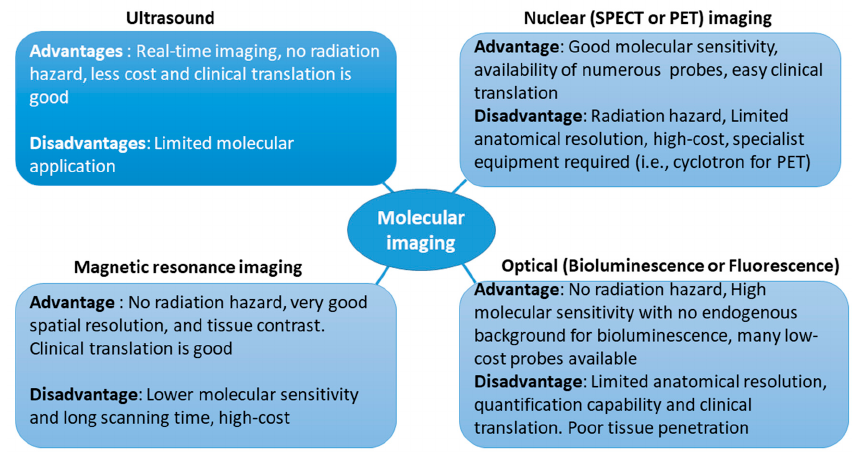
Figure 2. Advantages and disadvantages of different molecular imaging modalities. Positron emission tomography (PET), positron emission tomography; single-photon emission computed tomography (SPECT), single-photon emission computed tomography.